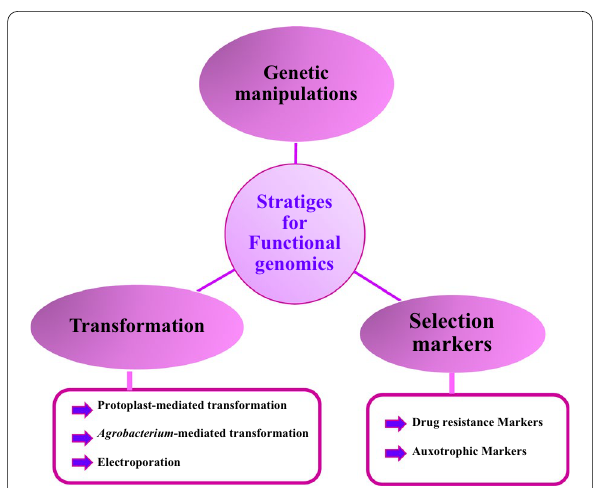
Fig. 3 Efficient strategies for fungal transformation conducted for functional genomic